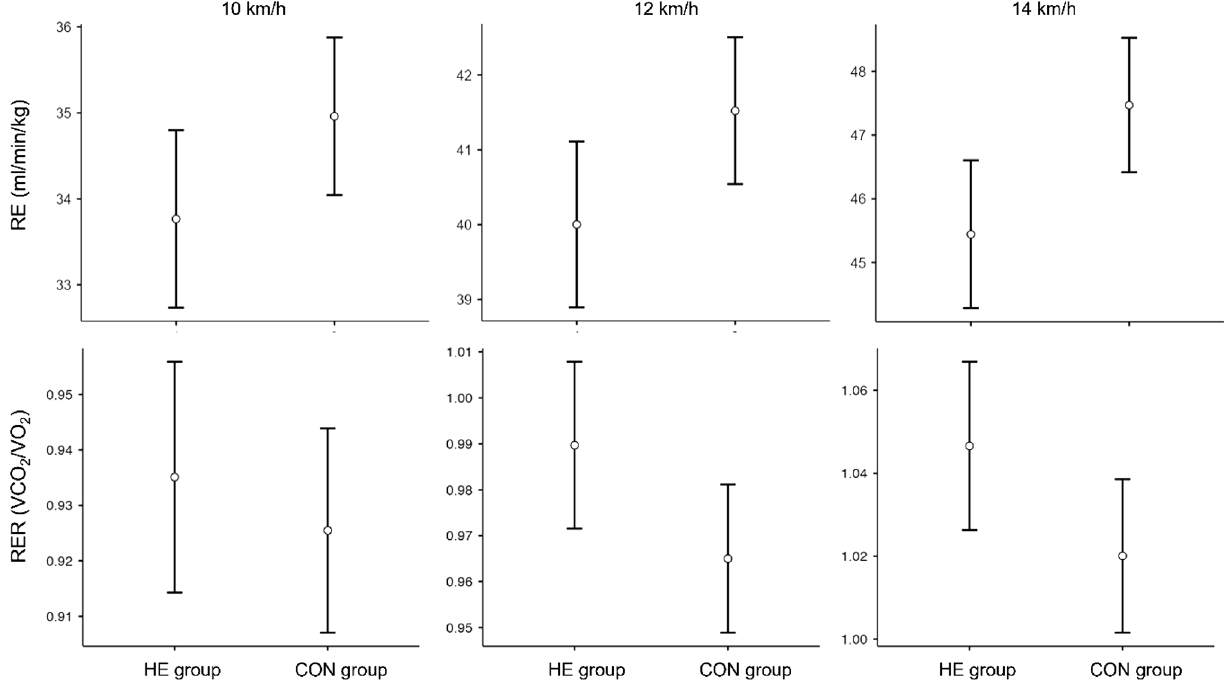
Figure 2. Group differences in the estimated marginal means of the post intervention values of RE and RER at three running speeds. Means (dots) and 95% confidence intervals (vertical lines) are